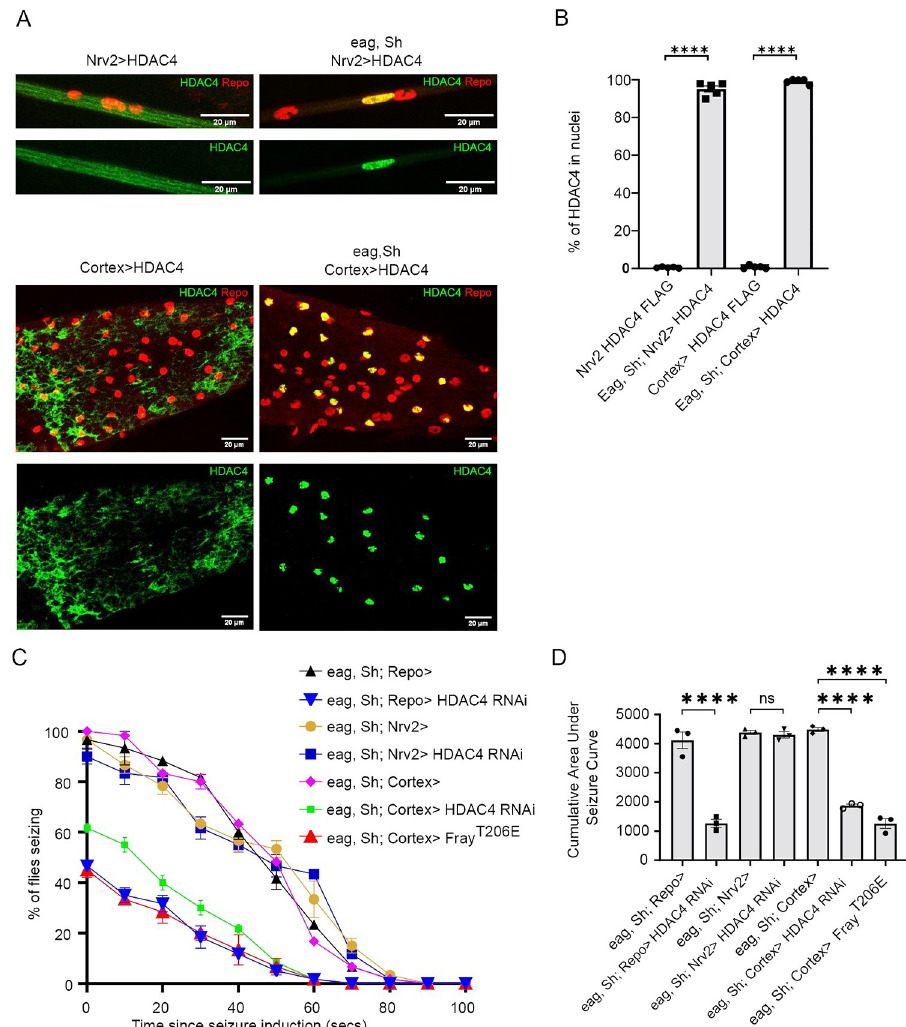
Fig 5. SIK3-HDAC4 signaling in Cortex glia is critical for seizure behavior. (A) Representative images of larval peripheral nerves showing HDAC localization in wrapping glia ( eag Shaker; Nrv2 > HDAC4) and cortex glia ( eag Shaker; Cortex > HDAC4) of eag Shaker mutants. eag Shaker mutants induce nuclear shuttling of HDAC4 in both wrapping and cortex glia. (B) Quantification of glial nuclear HDAC4. Data are represented as the amount of HDAC4 in the nucleus divided by the total amount of HDAC4, expressed as a percentage (C) Time course of vortex-induced seizures in eag Shaker with HDAC4 knockdown in all glia ( eag Shaker; Repo > HDAC4 RNAi), wrapping glia ( eag Shaker; Nrv2 > HDAC4 RNAi), and cortex glia ( eag Shaker; Cortex > HDAC4 RNAi). UAS-LexA RNAi was used as a control transgene in each glial subtype ( eag Shaker; Repo > , eag Shaker; Nrv2 > , & eag Shaker; Cortex > ). After seizure induction, the number of flies seizing were recorded every 10 seconds and plotted as a percentage of seizing flies. n � 3 groups of 10–20 flies per genotype per time point. (D) Quantification of area under the seizure curve for genotypes in (B). Statistical significance was determined using one-way ANOVA with Sidak’s multiple comparisons test; NS = not significant, ���� p < 0.0001.